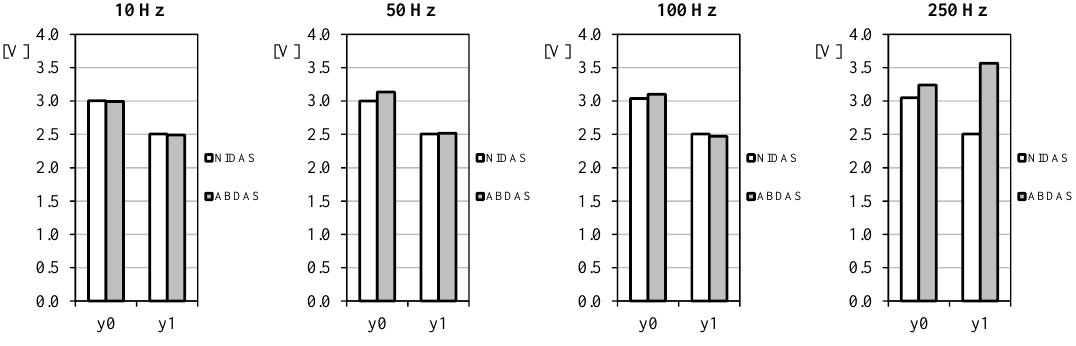
Figure 12. Offset, y 0 , and the first harmonic term, y 1 , extracted from the sampled data of same signal (Equation (3)) measured with NIDAS and ABDAS.